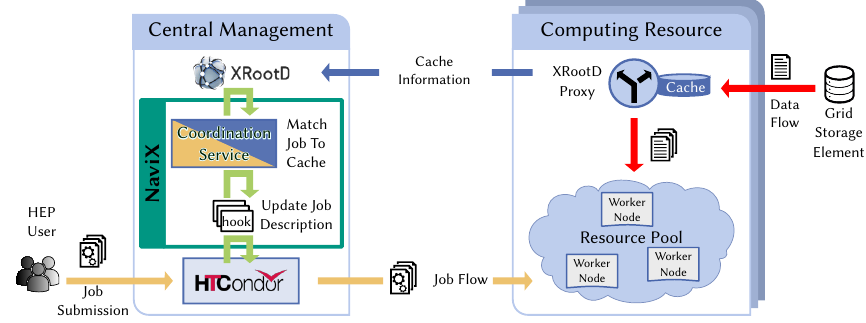
Figure 1. The NaviX coordination service connects the XRootD based cache proxy system with the HTCondor batch